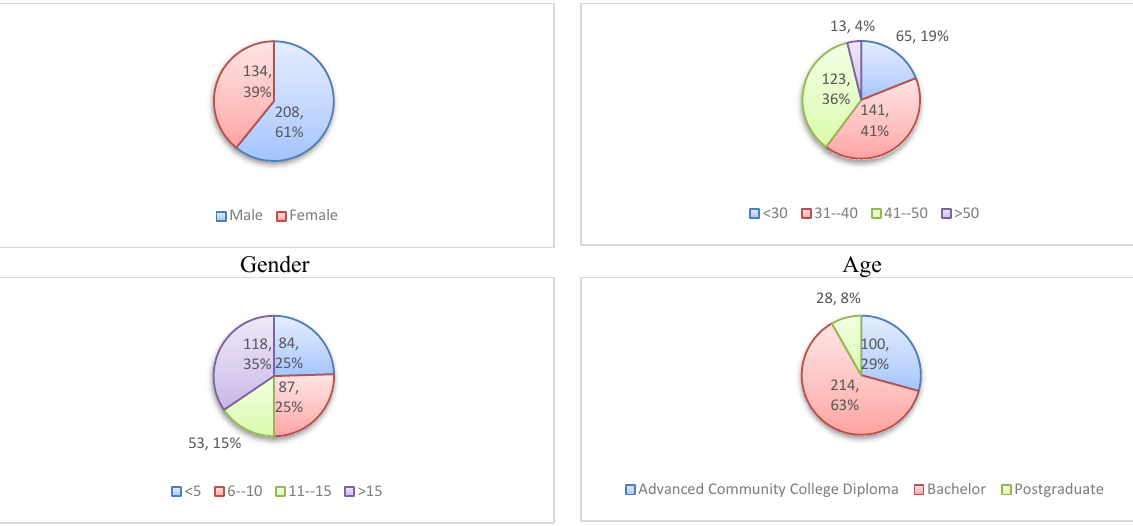
Fig. 2. Personal characteristics of the participants